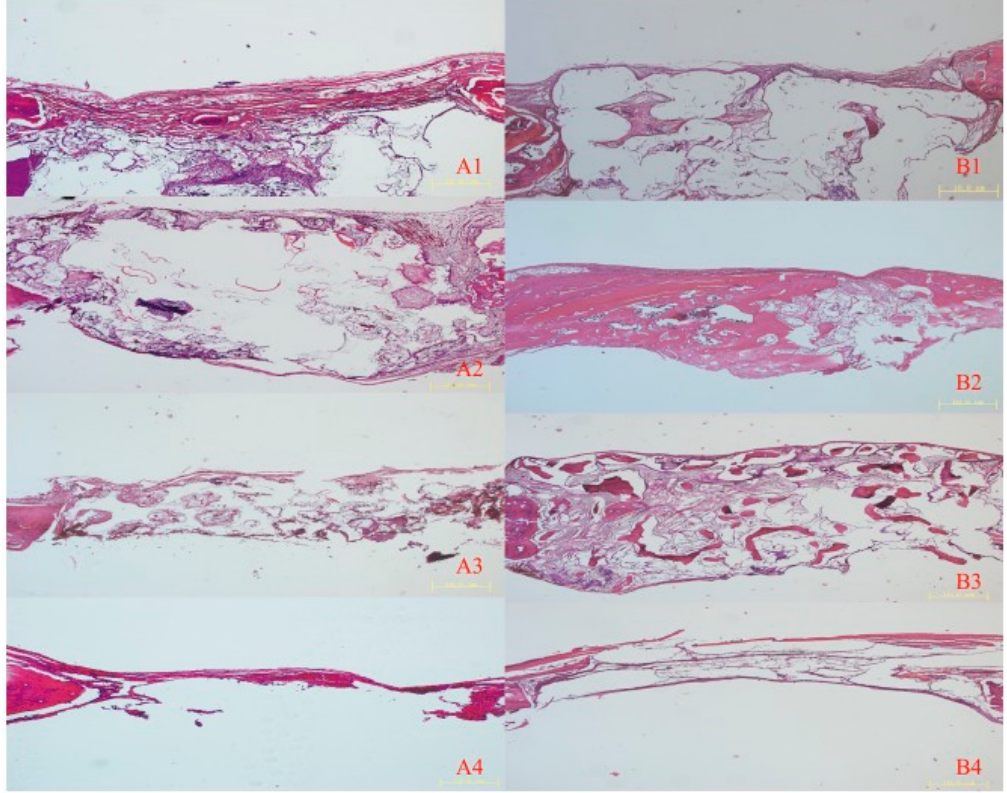
Figure 3. Hematoxylin and eosin images of implanted and control group after four and eight weeks. ( A ) Histological images of implanted (1) PLA / HA, (2) β -TCP, and (3) DBM sca ff olds, and (4) the control group four weeks after implantation. ( B ) Histological images of (1) implanted PLA / HA, (2) β -TCP, and (3) DBM sca ff olds, and (4) the control group eight weeks after implantation. Scale bars 10 µ m [122]. Combining HA with a fibrin sealant (FS) derived from snake venom exerted a beneficial e ff ect